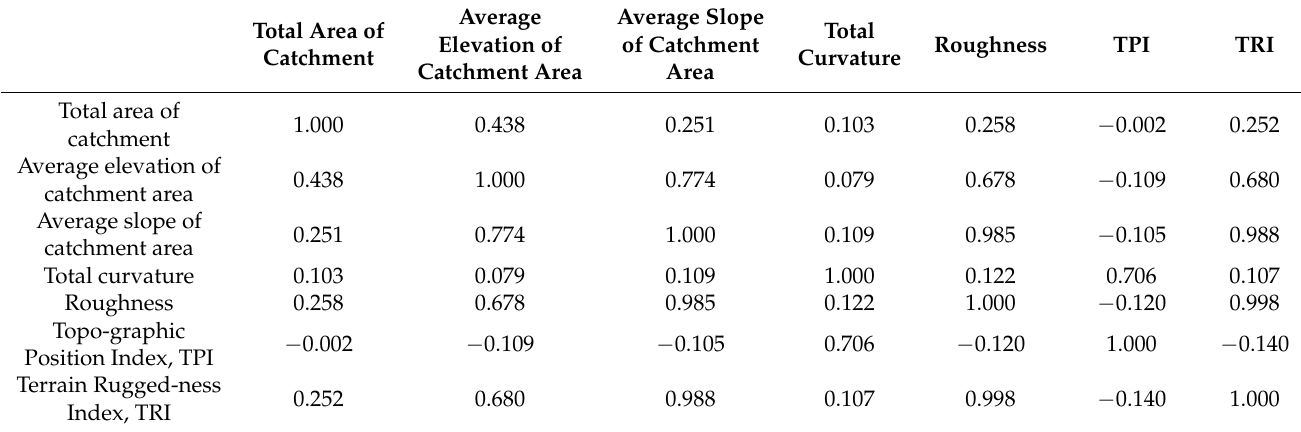
Table 8. Pearson’s correlation coefficients.